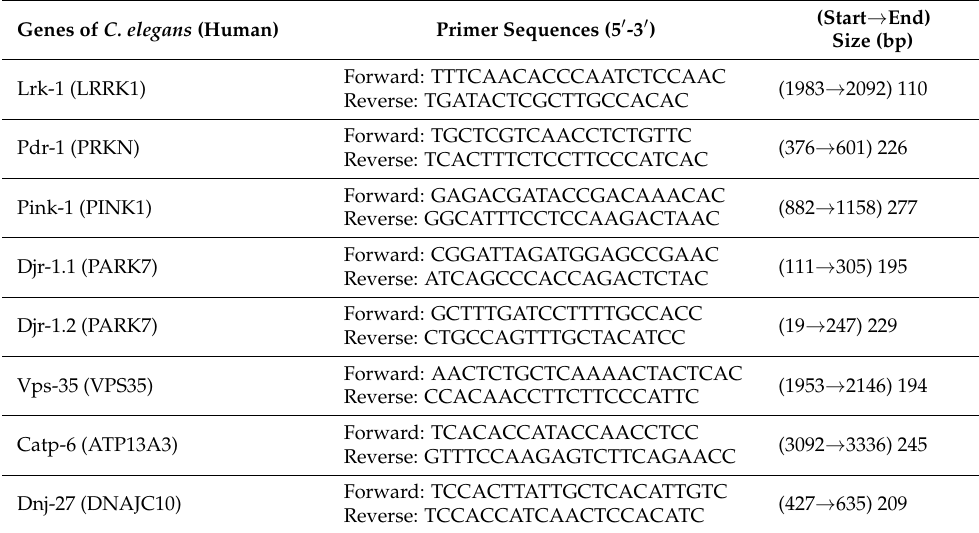
Table 1. Primers for real time PCR